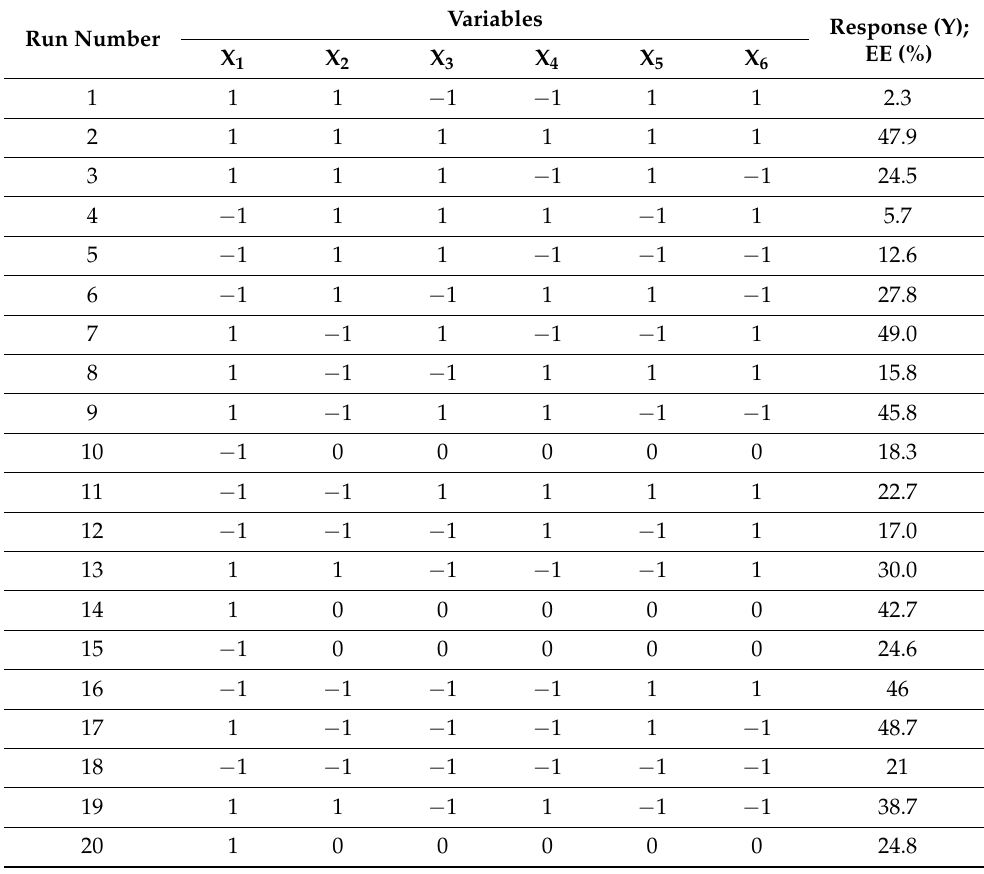
Table 3. Screening design of EGCG-niosome showing variables in coded values and response EE